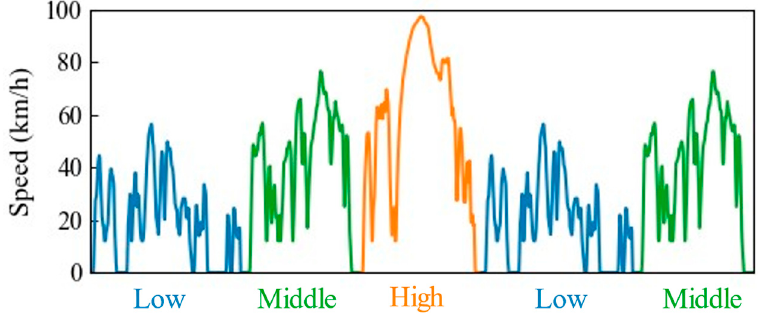
Figure 2. Evaluation cycle of one dynamic segment in WLTC Class 3b in Japan. Table 2. Parameters of test vehicles